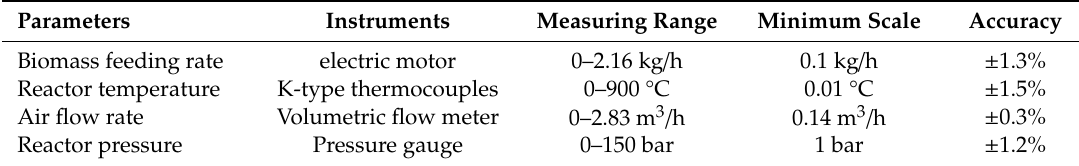
Table 2. Uncertainty analysis of the experimental